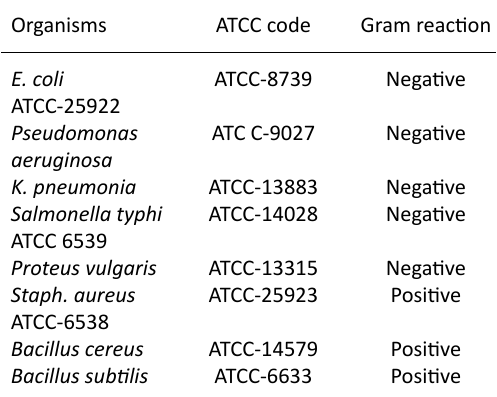
Table 1. list of provided type strains of bacteria with their ATCC codes Organisms